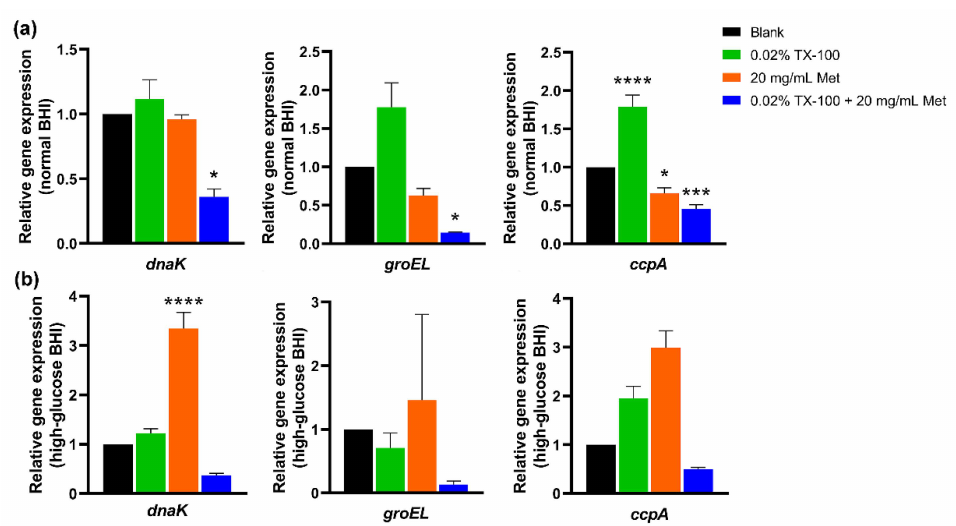
Figure 6. Relative gene expression of dnaK , groEL , and ccpA in E. faecalis. ( a ) in normal BHI; ( b ) in high-glucose BHI. (*: significant difference compared with the blank control group; * p < 0.05, *** p < 0.001, **** p < 0.0001).